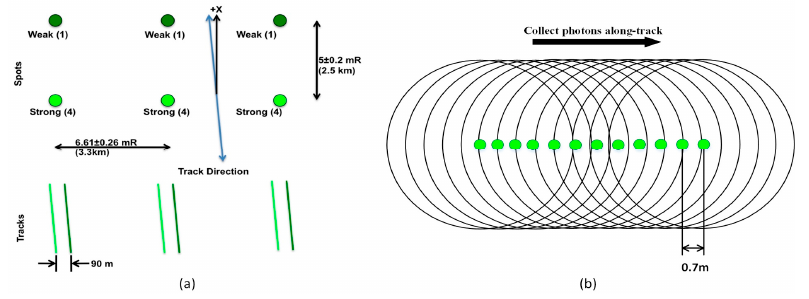
Figure 2. ICESat–2/ATLAS data acquisition mode: ( a ) laser beam distribution (https://icesat–2.gsfc.nasa.gov/science/specs, accessed on 20 October 2021); and ( b ) schematic diagram of sampling spacing interval.